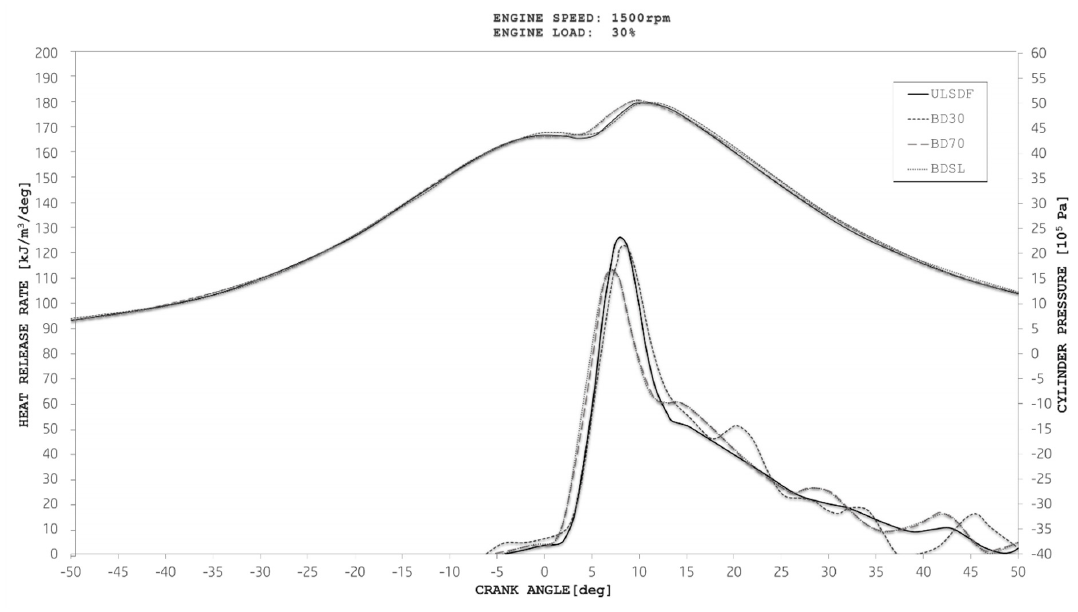
Figure 5. The dependence of fuels on the heat release rate and cylinder pressure (1500 rpm/30%).